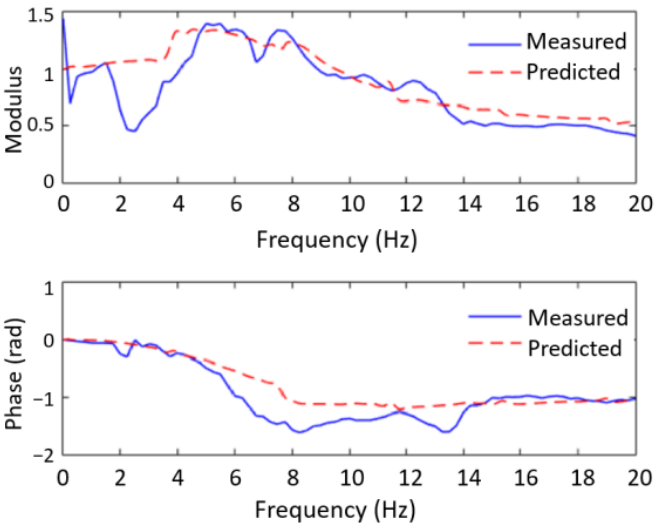
Figure 8. The modulus and phase of the Z -direction transmissibility of the seat.